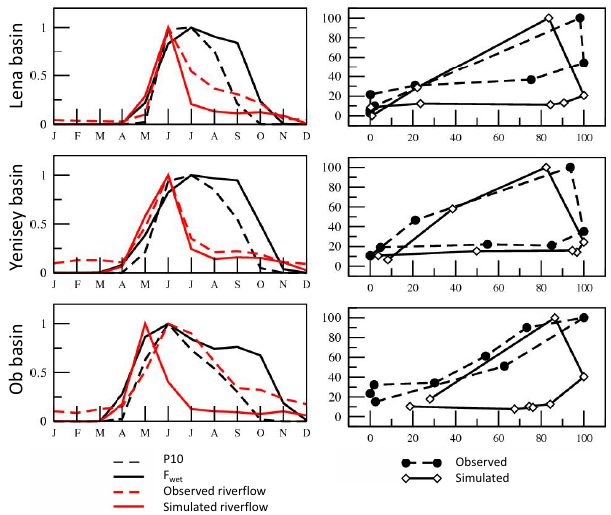
Fig. 9. (a) Mean seasonal cycle over 1993–2000 of river flow (nor- malized by mean monthly maximum) and of the inundated / wetland extents over three boreal basins (Lena, Yenisey and Ob basins). (b) Hysteresis relationship between river flow (in % of mean an- nual maximum) and inundation/wetland fractional extent (in % of mean annual maximum) for both observations and